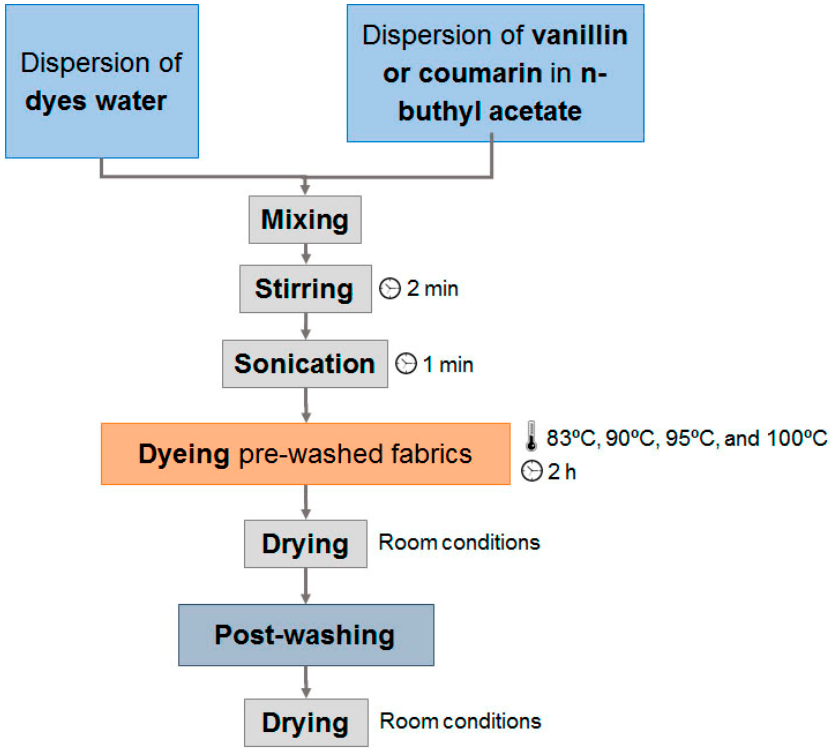
Figure 1. Experimental dyeing process used for this study.